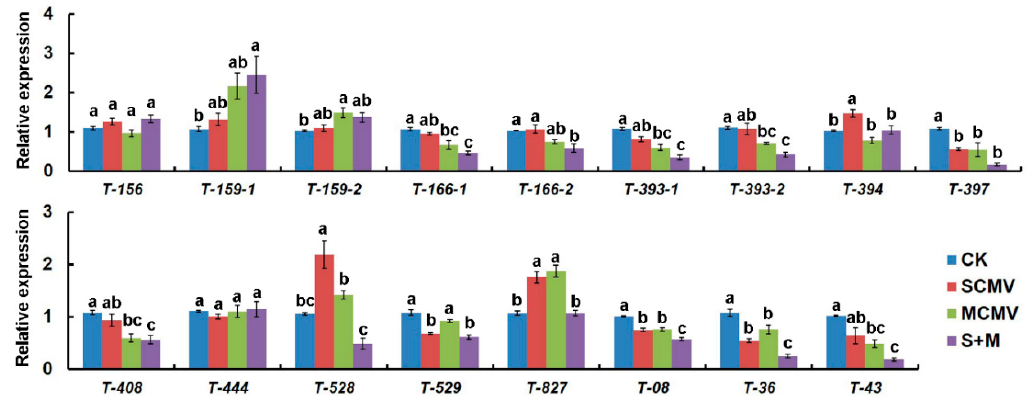
Figure 5. The expression of miRNA target genes in Mock-, SCMV-, MCMV-, and S + M-inoculated maize plants. The expression levels were determined by qRT-PCR at 9 dpi. Three independent experiments were conducted with at least three biological replicates each. Error bars represent the means ±SE. Different letters on the error bars indicate significant differences among samples according to ANOVA followed by Tukey’s HSD multiple comparison ( P < 0.05).